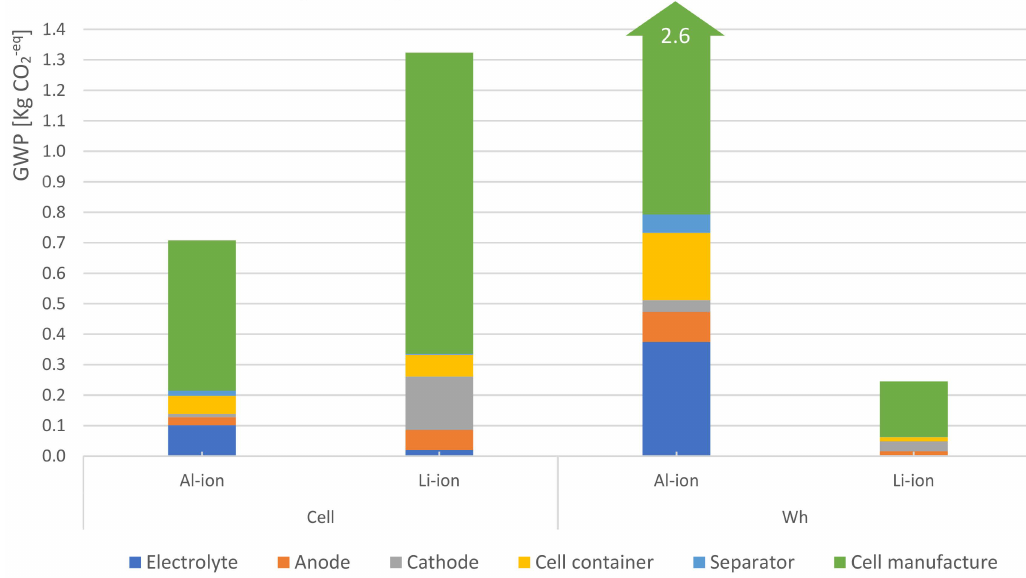
Figure 4. Breakdown of 18650-cell’s material composition and their absolute contribution to the global warming potential (GWP). Regardless of the functional unit or chemistry, the manufacturing process is the largest contributor to the GWP. On a per-cell basis, the Al-ion cell has a superior performance mainly because of the lack of copper in the anode. Its total contribution is about 0.7 kg of CO 2 − eq , while the Li-ion battery has a total contribution of 1.3 kg of CO 2 − eq . However, when the functional unit is based on energy content, the picture changes due to the low energy density of the Al-ion battery. Thus, in a per-watt-hour stored capacity basis, the Al-ion cell potentially has a footprint of 2.6 kg of CO 2 − eq , while the Li-ion battery barely contributes, with 0.25 kg of CO 2 − eq